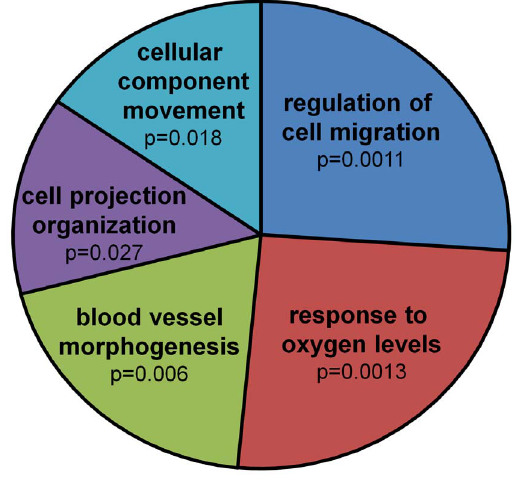
Figure 3. Functional annotation of 144 genes that are affected by a statistically significant interaction between age and fixation stability. Pie Chart view of REVIGO results: The single GO terms (Table S8 in File S3) are joined into clusters of related terms, visualized as sectors with different colours. Size of the sectors is adjusted (log10p-value) to reflect the p-values.